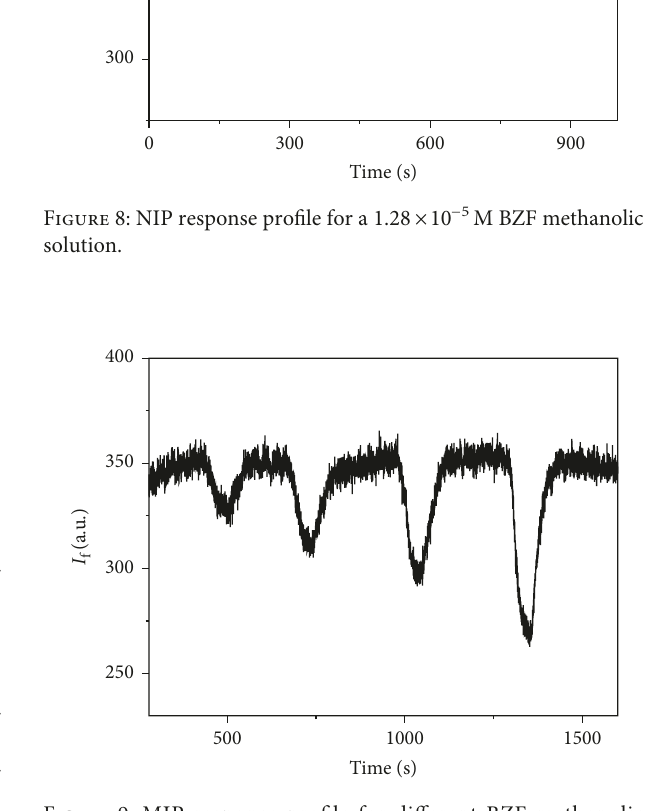
Figure 9: MIP response profile for different BZF methanolic solution concentrations: 1.78 ×